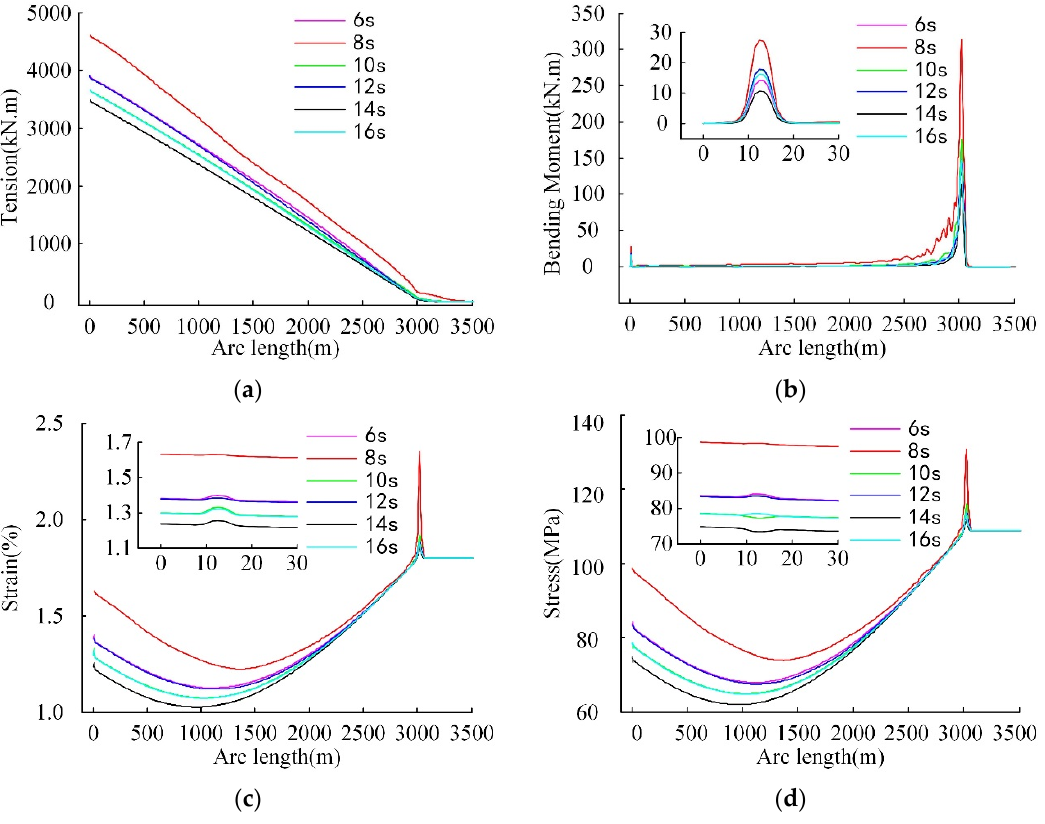
Figure 12. Effect of peak spectral period on pipeline dynamic responses: ( a ) Axial tension; ( b ) Bending moment; ( c ) Strain; ( d ) Stress.